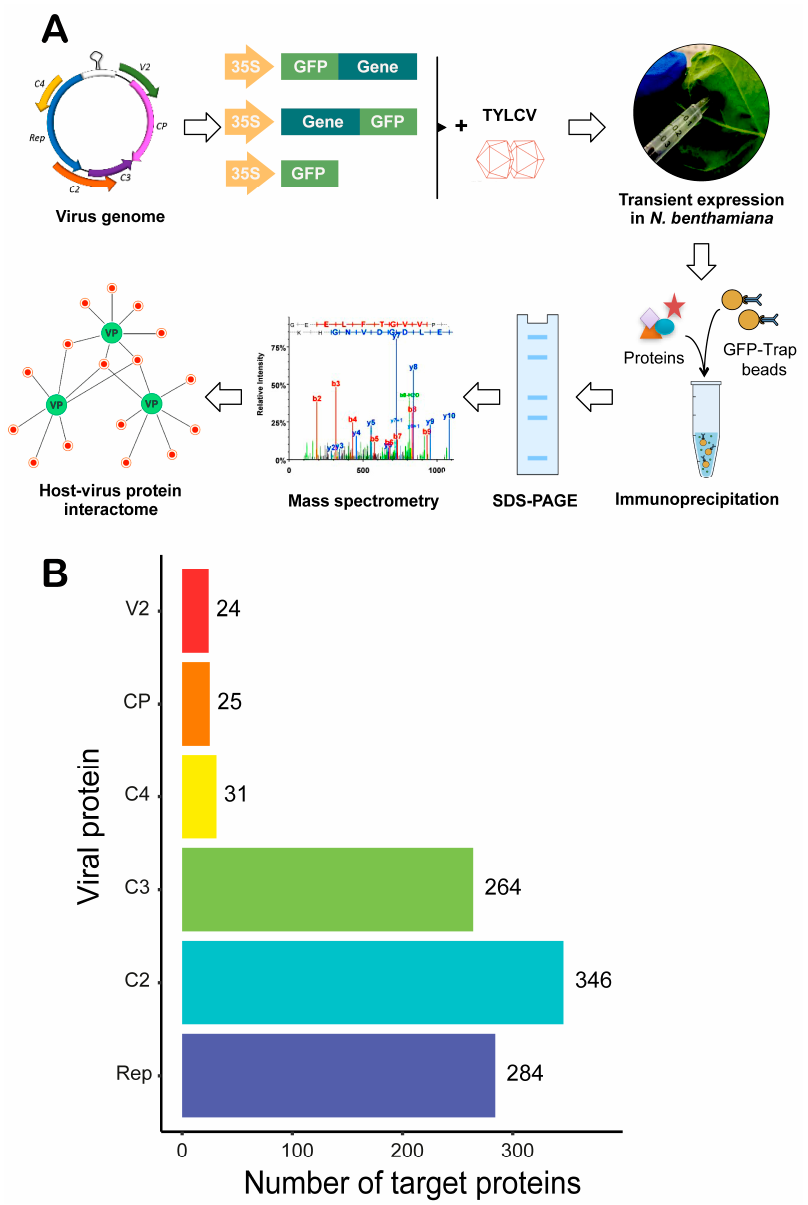
Figure 1. Schematic representation of the strategy followed to infer the TYLCV- Nicotiana benthamiana interaction network and number of N. benthamiana interactors identified. ( A ) Workflow of the strategy to identify interactors of TYLCV proteins in N. benthamiana by affinity purification-mass spectrometry analysis (AP-MS). TYLCV genes were cloned fused to GFP at their N- or C-terminus and transiently expressed in N. benthamiana leaves, together with a TYLCV infectious clone, by agroinfiltration. Two days later, total proteins were extracted and subjected to immunopurification using an anti-GFP resin. Immunopurified proteins were run in a sodium dodecyl sulfate-polyacrylamide gel electrophoresis (SDS-PAGE) gel, from which bands covering the entire lane were excised and sent for mass spectrometry analysis. Identified plant proteins co-purified with the viral GFP-fused proteins were used to infer the host-virus interactions network. In the example, viral proteins are depicted in green (VP), and interacting plant proteins are depicted in red. ( B ) Number of interacting plant proteins (referred to as target proteins) identified for each viral protein.